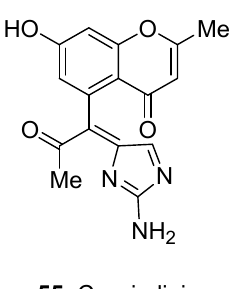
Figure 22. Cassiadinine ( 55